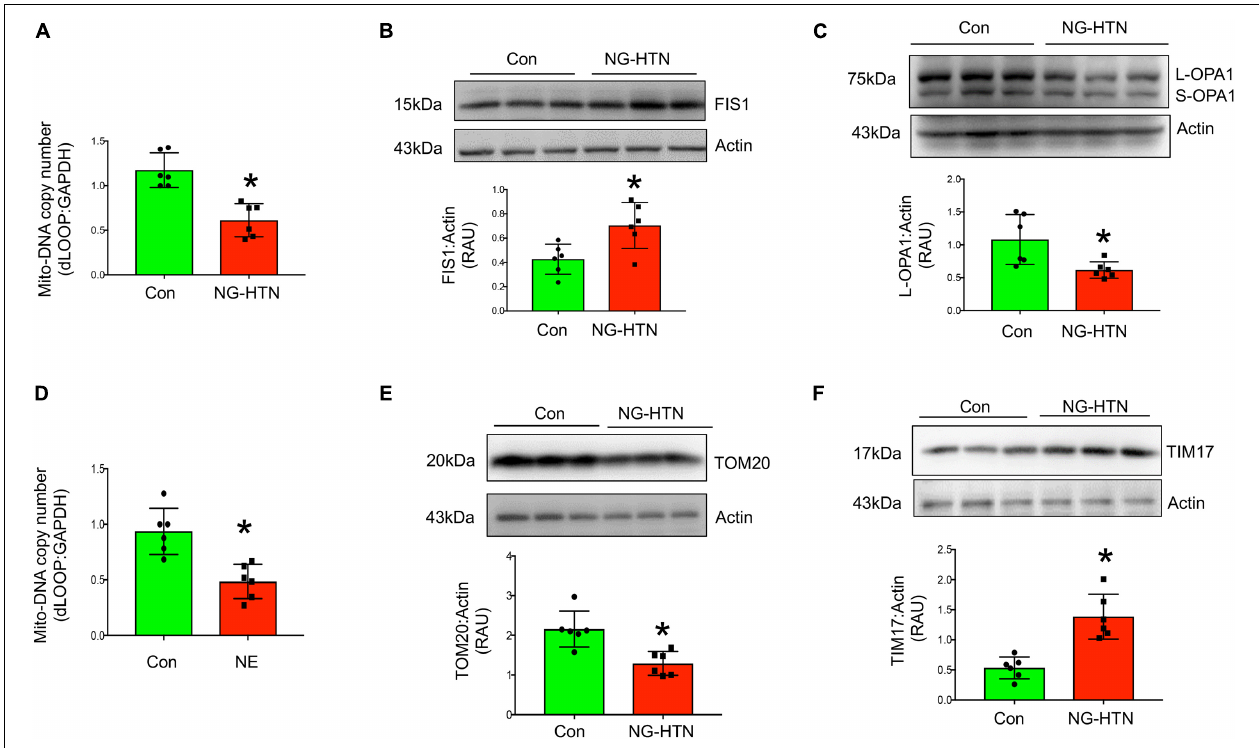
FIGURE 7 | Neurogenic hypertension induces shifts in cardiac mitochondrial dynamics and protein transport. (A) Measurement of relative d-LOOP/GAPDH DNA ratio by qPCR from control and NG-HTN hearts. (B,C) Western blot representative and quantification showing expression of FIS1 and OPA1 level, receptively, normalized to Actin in control and NG-HTN hearts. (D) Measurement of relative d-LOOP/GAPDH DNA ratio by qPCR in control and NE-treated H9c2. (E,F) Representative Western blot and quantification showing expression of TOM20 and TIM17 level, respectively, normalized to Actin. Values are mean ± SEM, dot represents n = 6 rats, * P < 0.05 vs. Control, Student’s t